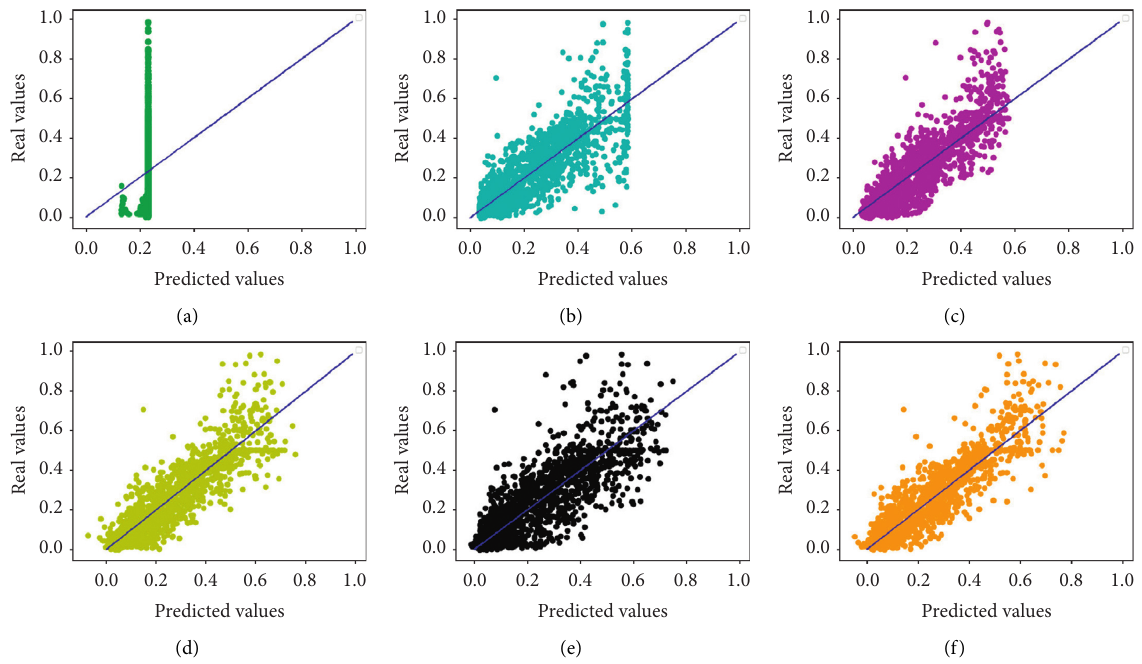
Figure 13: The scatter plot of the forecast and observed inflow for 12h lead times. (a) SVR, (b) DBN, (c) RFR, (d) GBRT, (e) LSTM, (f) Bagging-LSTM.